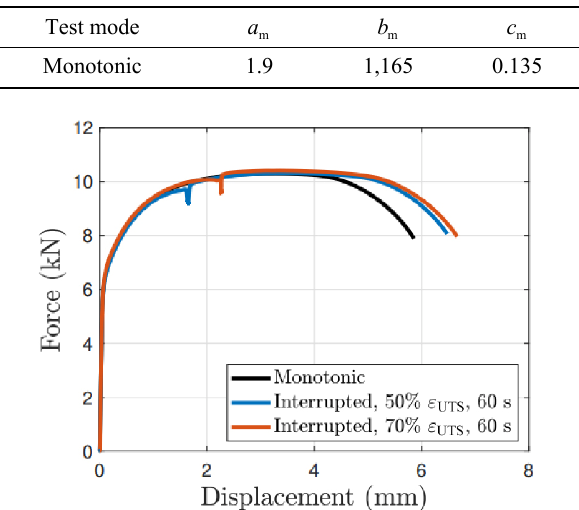
Table 1 Calibrated material parameters for HC fracture model for monotonic case.